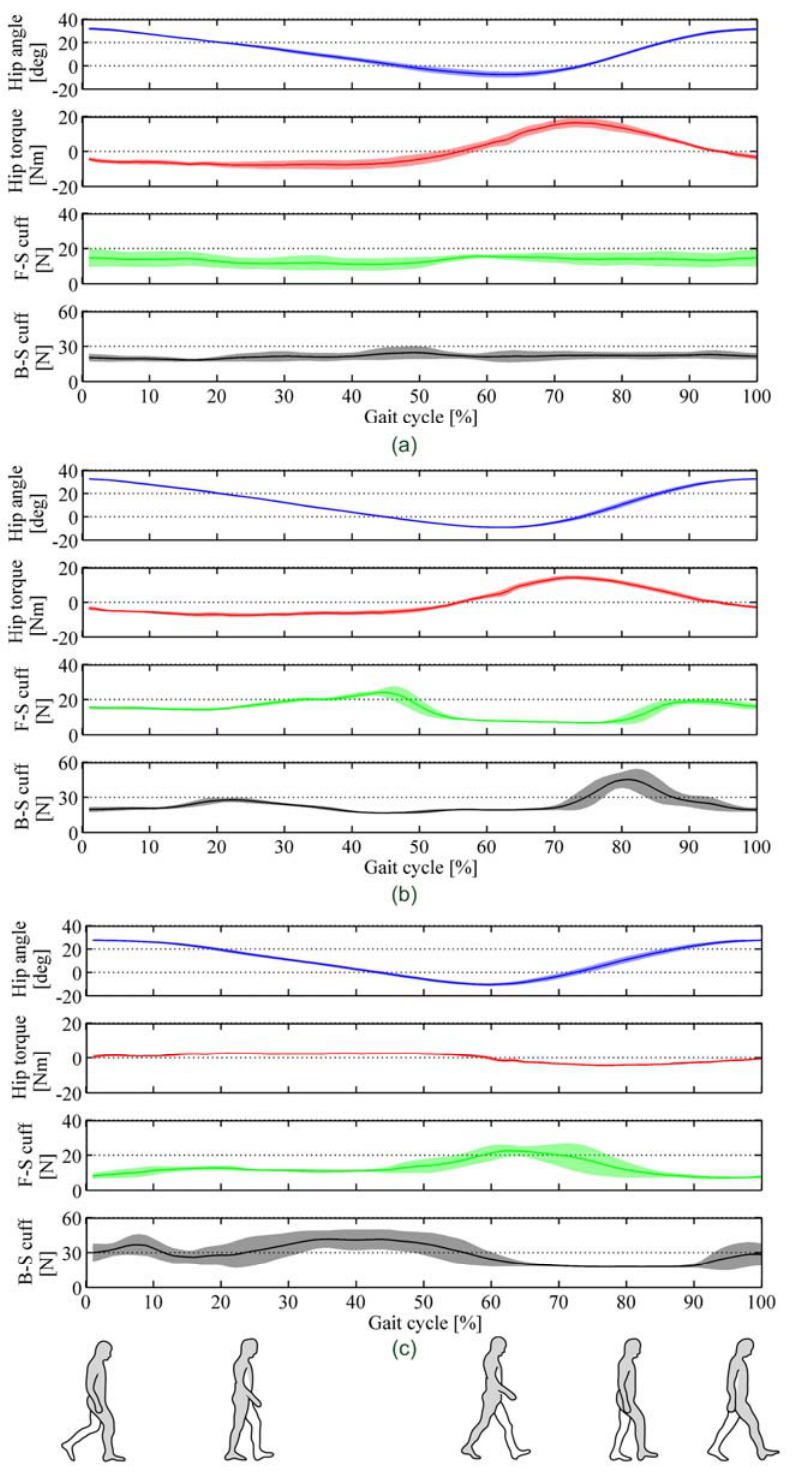
Figure 17. Hip kinematic and dynamic variables for Subject #1: right-leg hip flexion-extension joint angle and torque, and total force recorded by front- (F-S) and back-side (B-S) thigh-cuff PSPs. Data are averaged over 20 gait cycles (solid line), and shown along with the standard deviation contour (shadowed), for three conditions: ( a ) gait velocity is 2.5 km/h, with assistive torque; ( b ) gait velocity is 4 km/h, with assistive torque; ( c ) gait velocity is 4 km/h without assistive